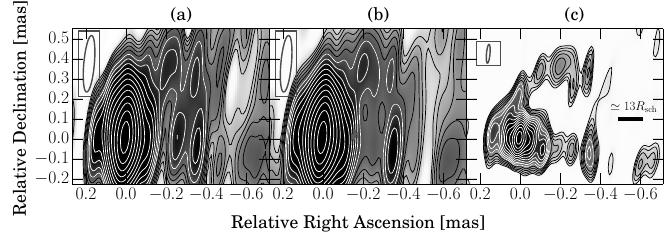
Figure 5. CLEAN and BSMEM imaging results for the 2009 May GMVA visibility data. For each panel, ( a ) normal CLEAN (beam : 0.049 0.290 mas, 5.99 ◦ ), ( b ) BSMEM image with the same beam as ( a ), × − and ( c ) super-resolved BSMEM image (beam: 1/3 of the CLEAN beam size). In panel ( a ) and ( b ) the lowest contour level is 2.0 mJy/beam, which roughly corresponds to 7 sigma for the CLEAN map. For panel ( c ) the lowest level is 1.0